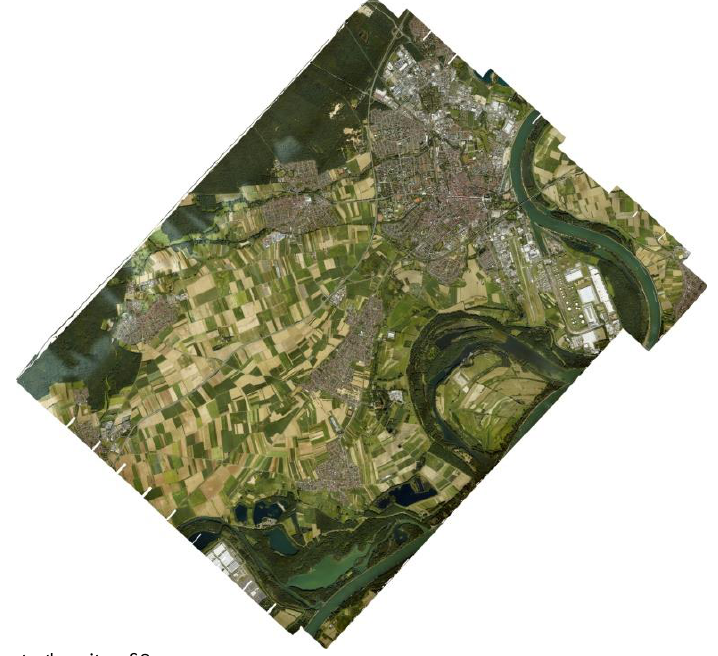
Figure 1. The project area close to the city of Speyer